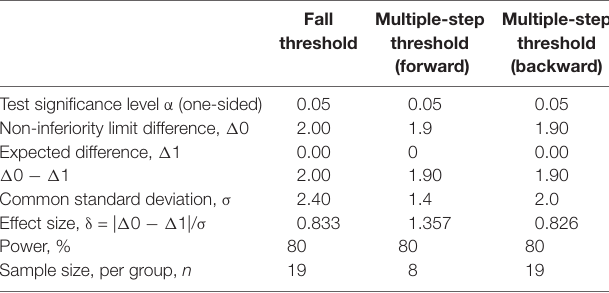
TABLE 4 | Sample size